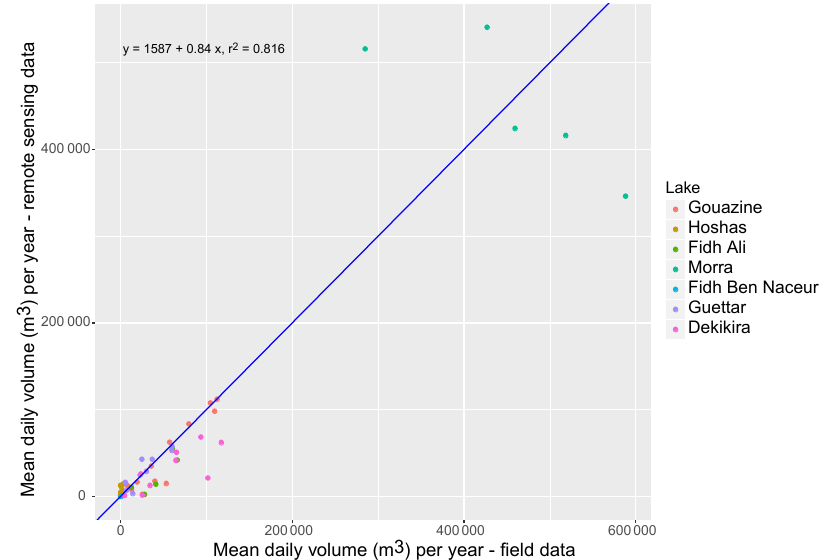
Figure 18. Mean daily volume per year with MNDWI on Landsat imagery vs. field data over 1999–2014 across all seven lakes.